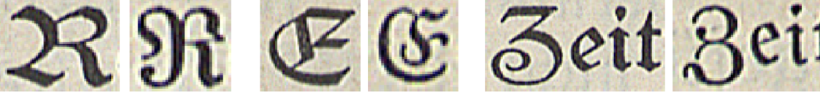
Fig. 4 Different types of gothic/black letter